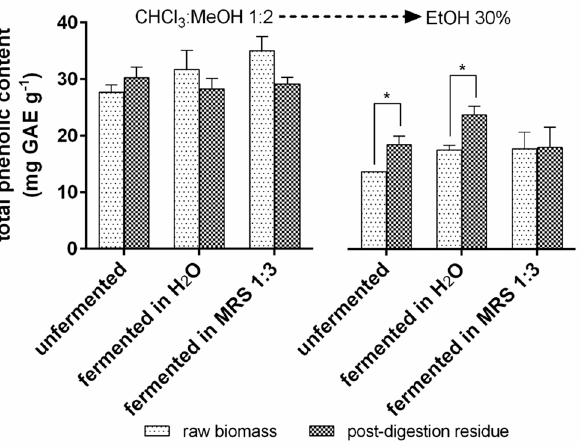
Figure 10. Total phenolic content (mg GAE g − 1 ) in the CHCl 3 :MeOH 1:2 and 30% EtOH T. lutea F&M-M36 extracts for the two substrates (raw biomass and post-digestion residue) and the different conditions analysed (unfermented, fermented in H ₂ O, and fermented in MRS 1:3). Data are expressed as mean ± standard error. * significant differences ( p < 0.05).